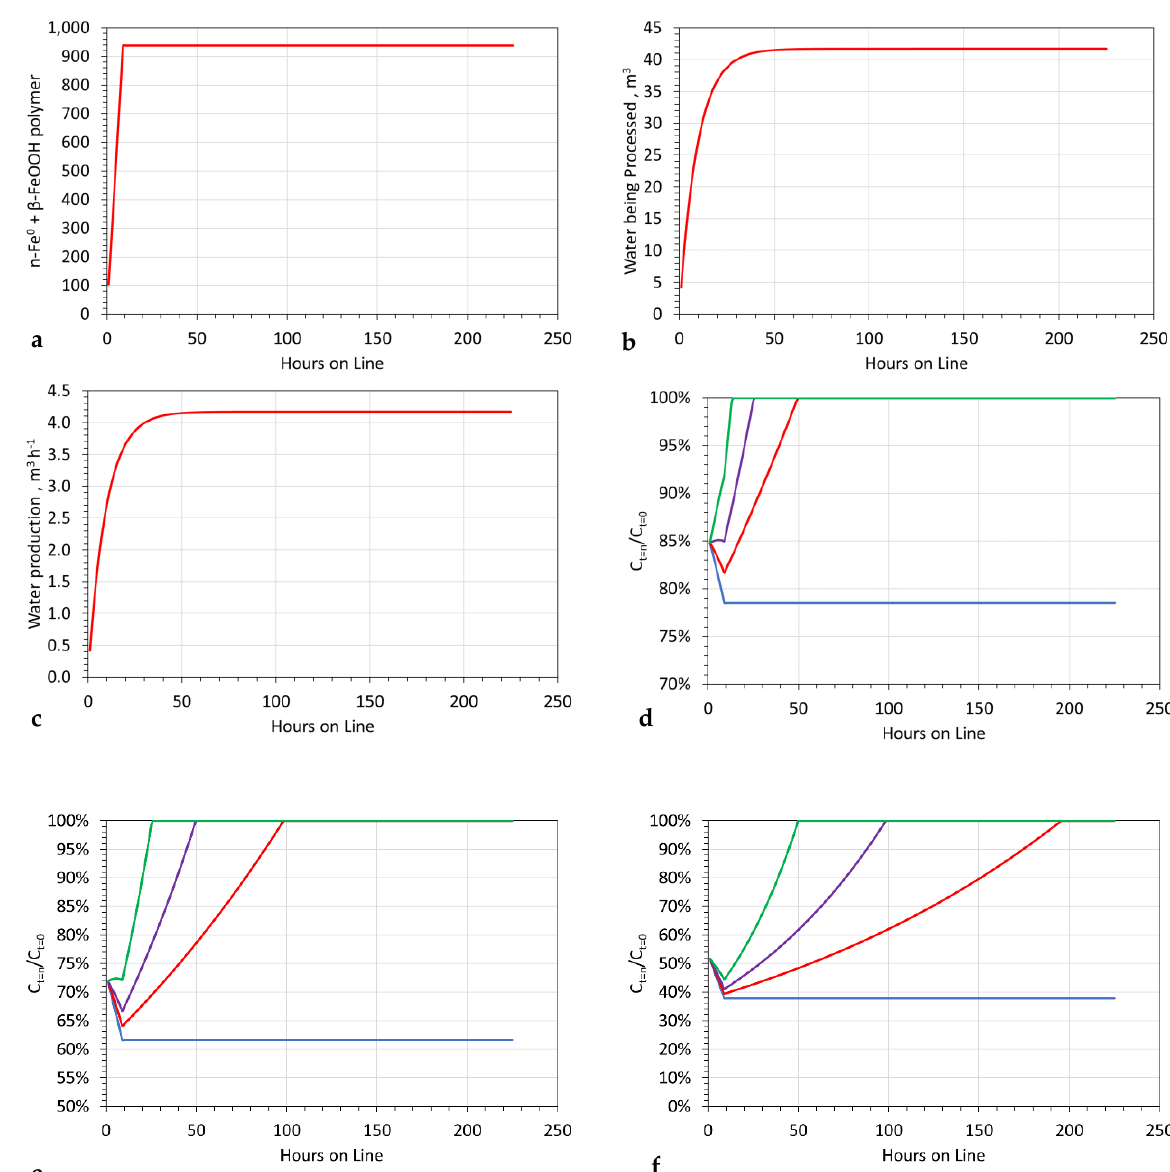
Figure 15. Modeled desalination outcomes for the reactor shown in Figure 13 with a n-Fe 0 charge. R r = 90%; n-Fe 0 is added at a rate of 25 g L −1 for the first 10 h. All n-Fe 0 within the reaction environment is recycled. ( a ) n-Fe 0 (kg) provided to the reactor versus hours on line; ( b ) water volume being processed in the reactor versus time; ( c ) partially desalinated water production as a function of time; ( d ) n-Fe 0 , P w = 25 g L −1 ; expected value of C t = n / C t = 0 versus hours on line for: [ d ] = 1: ( e ), n-Fe 0 , P w = 50 g L −1 ; expected value of C t = n / C t = 0 versus hours on line for: [ d ] = 1: ( f ), n-Fe 0 , P w = 100 g L −1 expected value of C t = n / C t = 0 versus hours on line for: [ d ] = 1; blue; [ d ] = 1.005: red; [ d ] = 1.01: purple; [ d ] = 1.02: green.